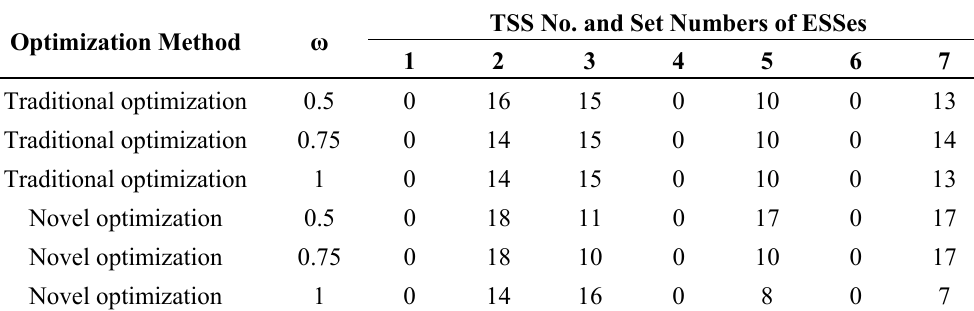
Table 9. Optimized location and size of